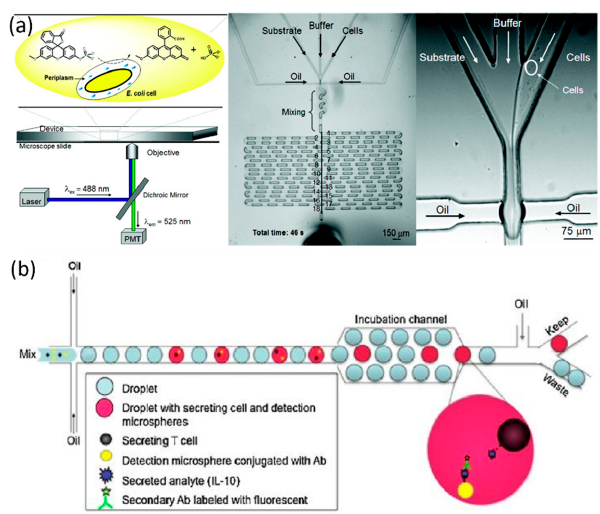
Figure 4. Microfluidic droplets enabling single-cell proteomic analysis. ( a ) Individual E coli and substrate 3- O -methylfluorescein-phosphates were encapsulated within single droplets where the